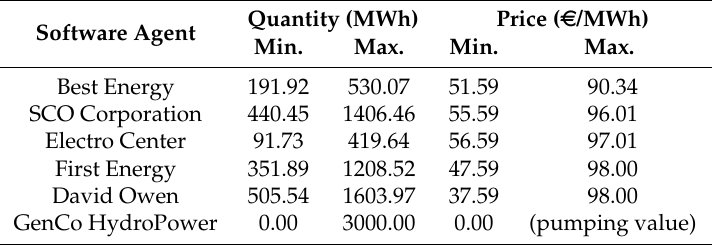
Figure 6. Typical daily profile: forecast, real production and deviation. Table 2. Buyer agents and data associated with their